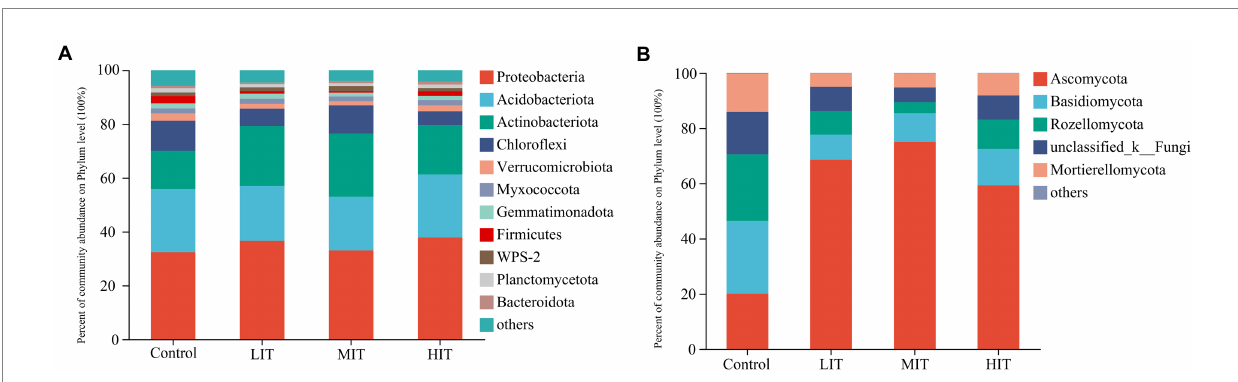
FIGURE 2 Relative abundance of the dominant groups of bacterial (A) and fungal (B) communities at the phylum level among the four thinning